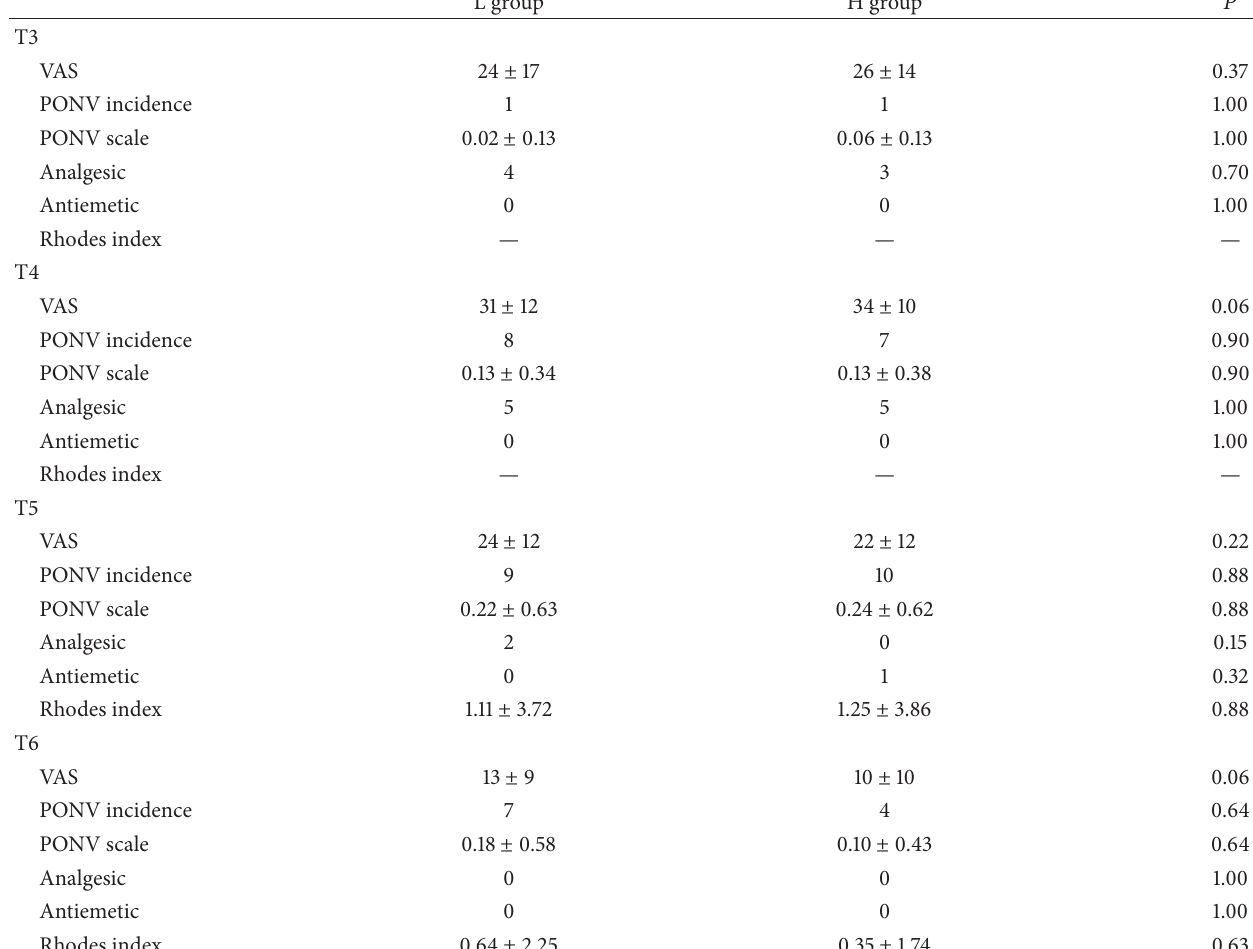
Table 3: Postoperative pain assessed by a visual analogue scale (VAS) and postoperative nausea and vomiting (PONV). L group H group